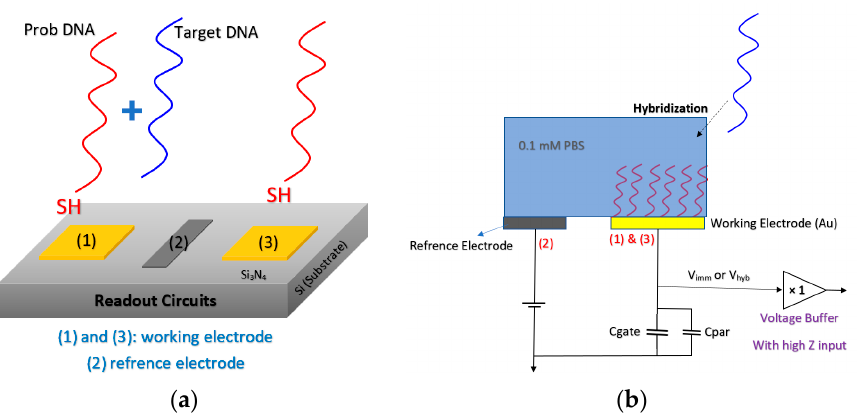
Figure 14. The sensor proposed by Lee et al. in order to detect the RNA of H5N1 AIV-based on hybridization detection on the surface of the gold electrode: ( a ) Showing the working electrode and reference electrode arrangement which are dedicated for probing and reference reaction; ( b ) a brief schematic of circuit and the way it has been connected to the reference and working electrodes.